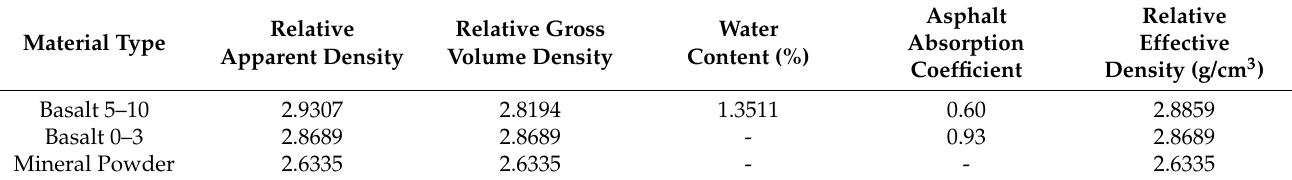
Table 2. Technical indexes of basalt aggregate and mineral powder.